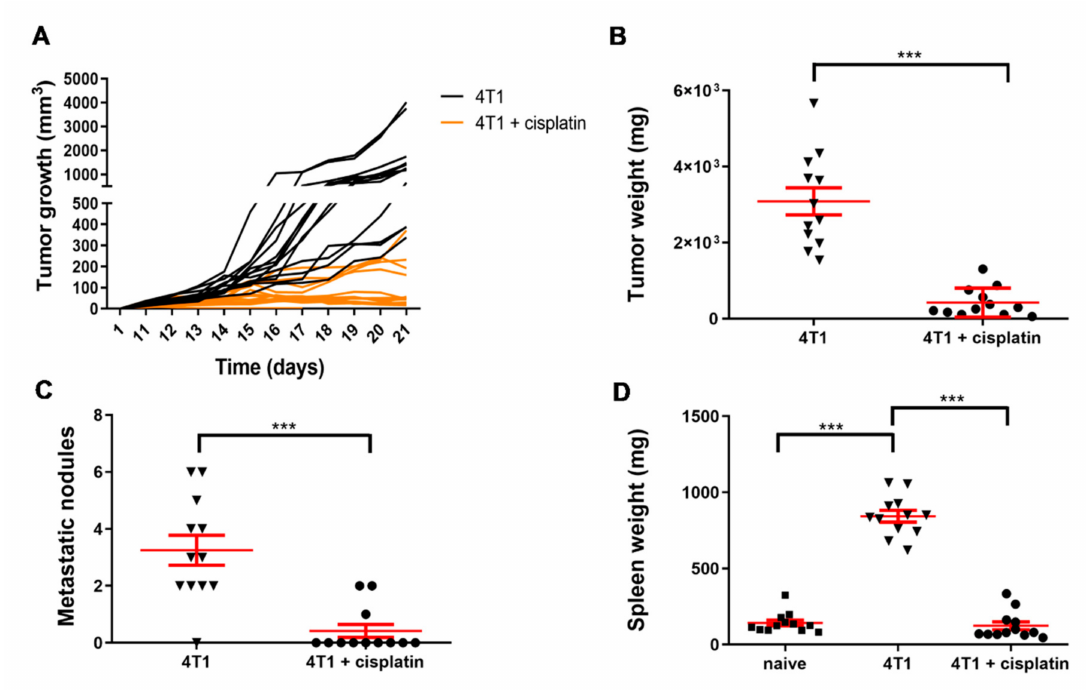
Figure 2. Cisplatin treatment reduced 4T1 tumor growth, the number of lung metastatic nodules and the weight of the spleen. The 4T1 cells (1.2 × 10 5 ) were transplanted by the injection into the mammary fat pad of BALB / c mice ( n = 12). Tumor growth was monitored daily ( A ). On the 23rd day mice were euthanized and the weight of the tumors ( B ), the number of metastatic nodules on the lungs ( C ), and the weight of the spleens were measured ( D ). Individual values and arithmetic mean values of the samples ± standard error of the mean (SEM) are plotted, statistical significance was set to *** p <